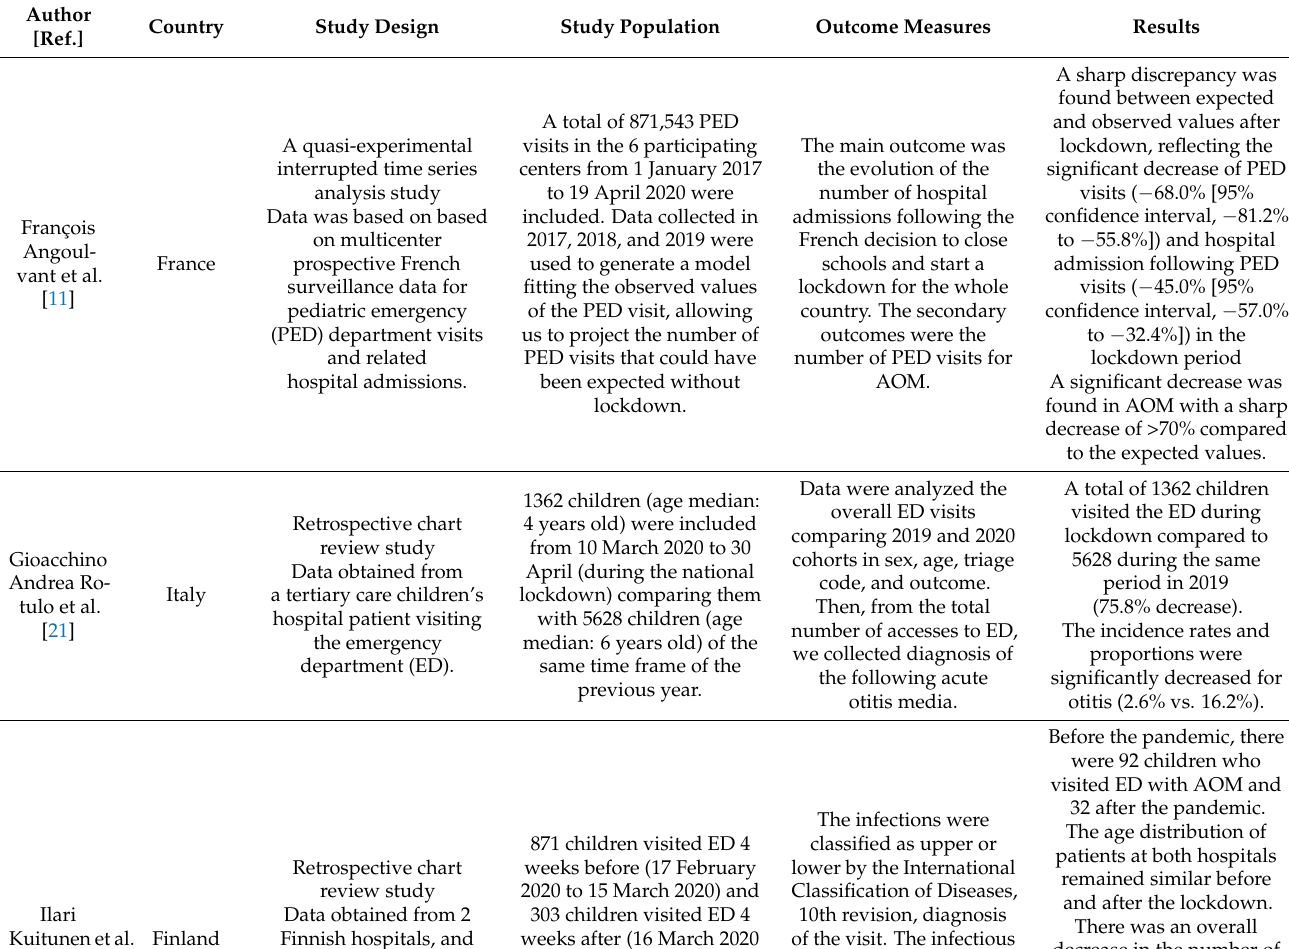
Table 4. Summary of studies on visitations to the emergency department for OM during the COVID-19